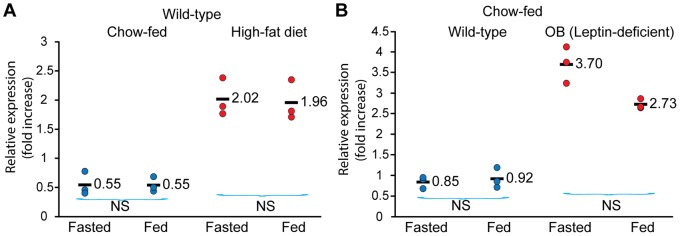
Expression of Ildr2 in liver is increased by adiposity through high-fat diet or leptin deficiency.Expression of Ildr2 was determined by qPCR, normalized to 36B4 in mice sacrificed after either fasting for 24 hr or after fasting for 24 hr and followed by a 12-hr refeeding period. (A) Wild type B6 mice at 6 weeks of age were fed ad libitum either chow or a high fat diet (60% of kcal from fat) for 3 additional months. (B) Chow-fed wild type B6 and leptin-deficient OB mice (B6.Cg-Lepob/J) were purchased at 9 weeks and sacrificed at 10 weeks of age. Wild-type mice fed a high fat diet and genetically obese mice showed a similar (3.6 to 3.7-fold) increase in Ildr2 liver expression compared to age- matched wild-type mice (p value <.01 ) regardless of feeding status.